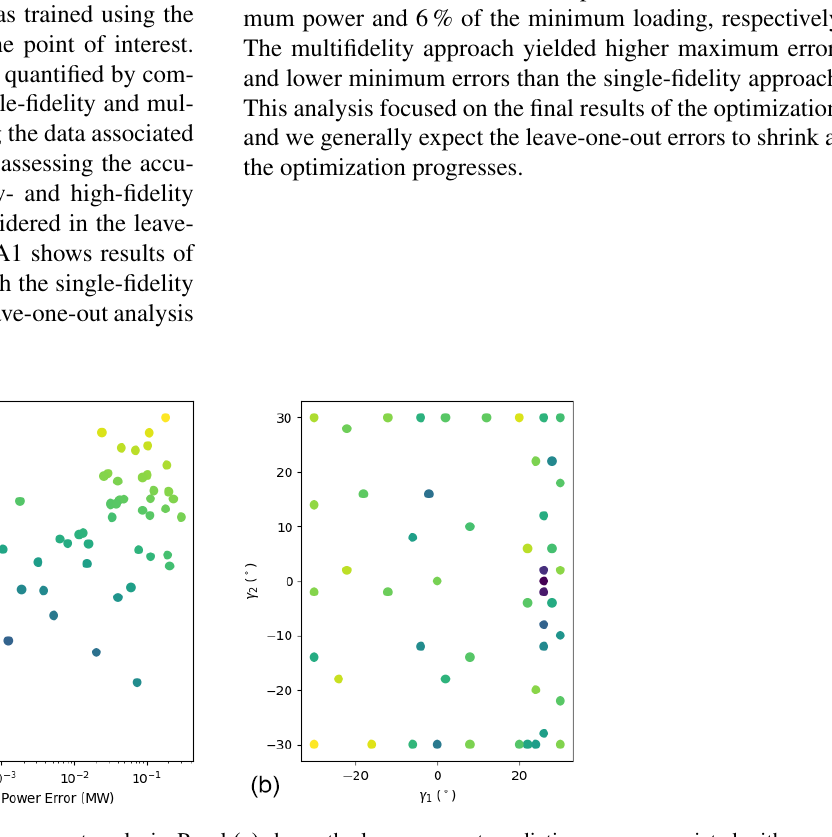
Figure A1. Results of the single-fidelity leave-one-out analysis. Panel (a) shows the leave-one-out prediction errors associated with power and loading, and the points are colored by the sum of both errors. The same points are plotted in panel (b) , showing their associated γ 1 and γ 2 values.